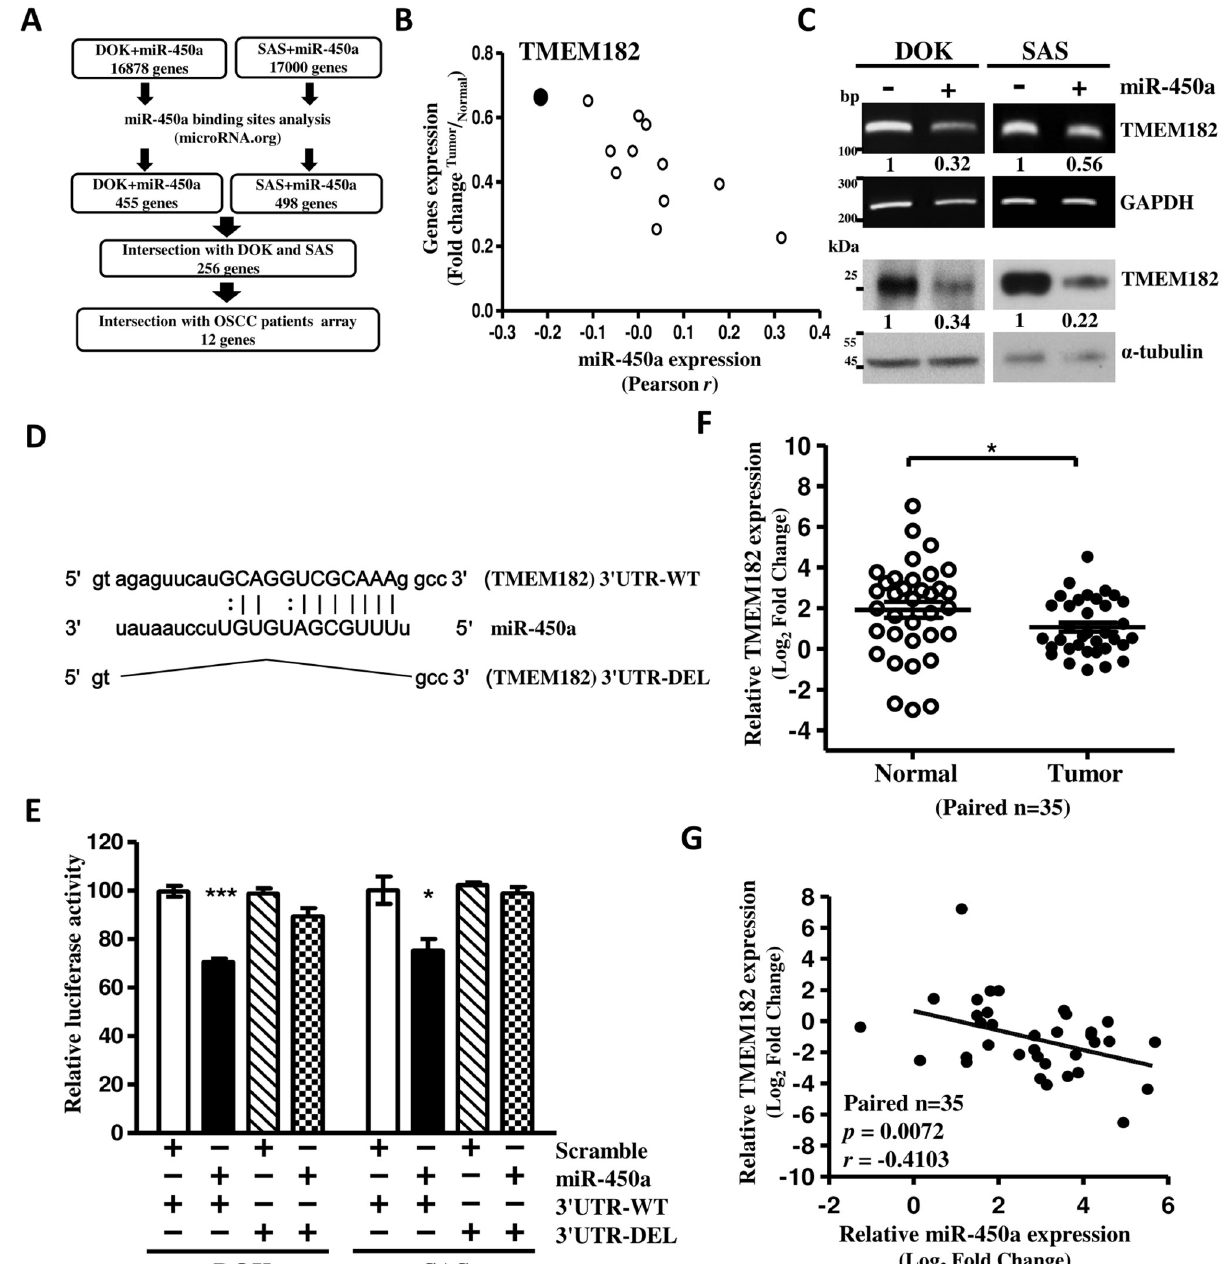
Fig 2. miR-450a decreases TMEM182 by directly targeting 3’-UTR. (A) Flowchart for in silico analysis of miR-450a-regulated genes from OSCC cell lines (DOK and SAS cells) and our previous OSCC clinical samples data (n = 40)(accession number GSE37991). (B) Twelve of miR-450a-targeted candidates were evaluated on the basis of down-regulated rates (fold change) and Pearson r correlation against miR-450a expression in previous OSCC clinical samples (n = 40) data. TMEM182 (black circle) presented the best negative correlation with miR-450a. (C) Levels of TMEM182 changes in DOK and SAS cells were assessed with RT-PCR and western blot after miR-450a mimics/scramble transfection for 48 hrs. Numerical values for band intensities are shown below the gels. The values were quantitated by densitometry and normalized to GAPDH or α -tubulin. (D) Schematic representation of predicted miR-450a binding sequence in the 3’-UTR of TMEM182 with wild-type form (3’UTR-WT), and with miR-450a binding site deleted form (3’UTR-DEL). (E) miR-450a regulated TMEM182 3’-UTRluciferase activities of 3’-UTR-WTor 3’-UTR-DEL in DOK and SAS cells after 48 hrs transfection as described in panel. The relative luciferase activities are the ratios of Renilla luciferase normalized to scramble. (F) Levels of TMEM182 in OSCC human samples (n = 35) was assessed with qPCR. (Student’s t test, p < 0.05). G , The Pearson r correlation between miR-450a and TMEM182 levels in OSCC patients (n = 35) by qPCR analysis. MiR-450a expression was normalized to RNU44 and TMEM182 expression was normalized to GAPDH. Data was represented as mean ± SEM; � P < 0.05; �� P < 0.01; ��� P < 0.001.